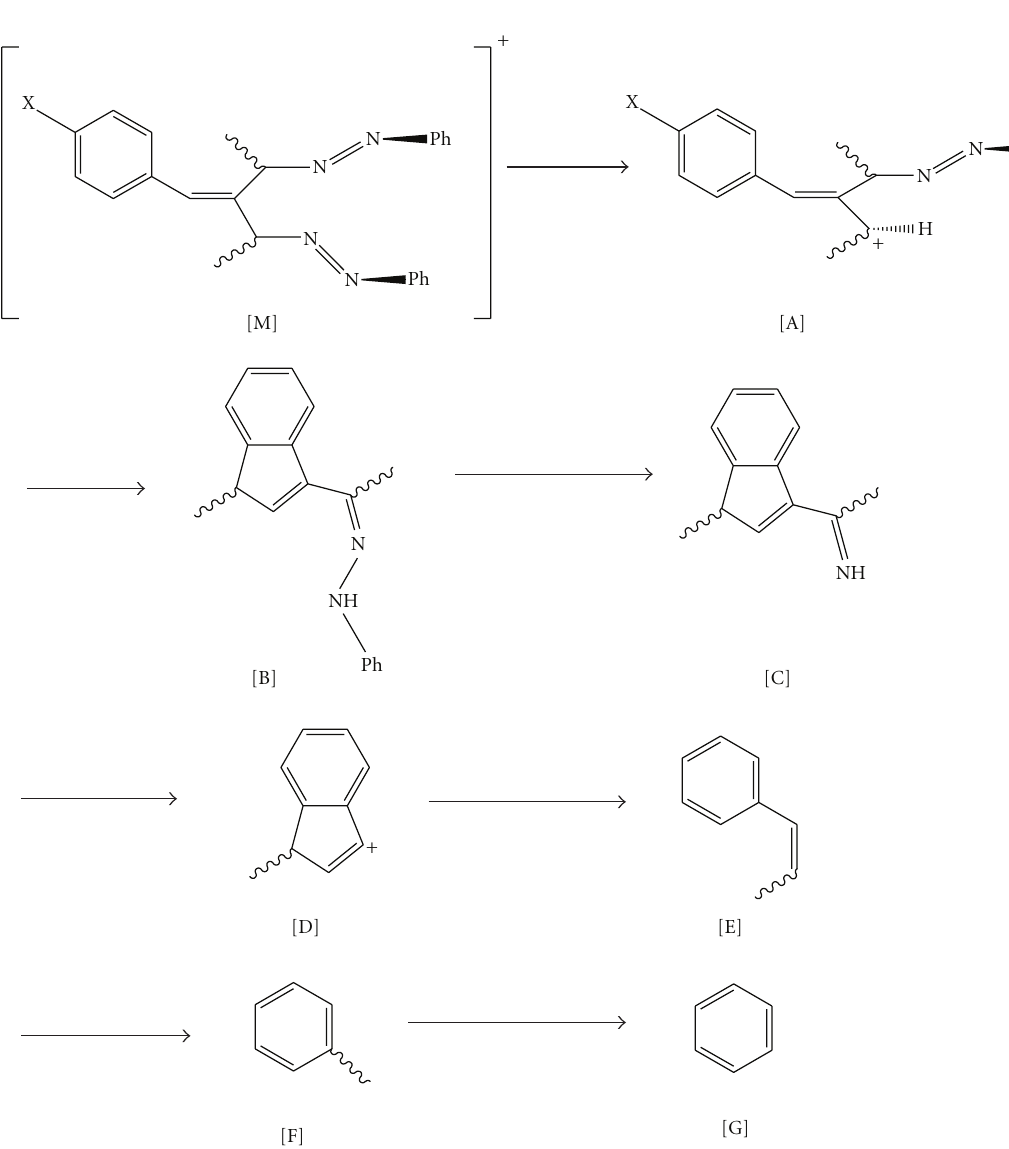
Scheme 1: The general route of fragmentation of